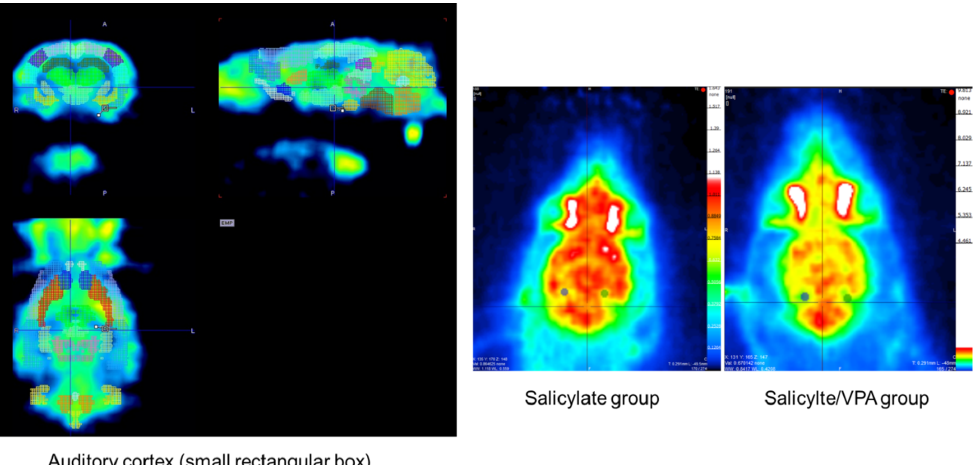
Figure 7. The average SUVs of each auditory cortex in the salicylate group were 0.91198 and 0.84824, whereas those in the salicylate/VPA group decreased to 0.48918 and 0.48345.